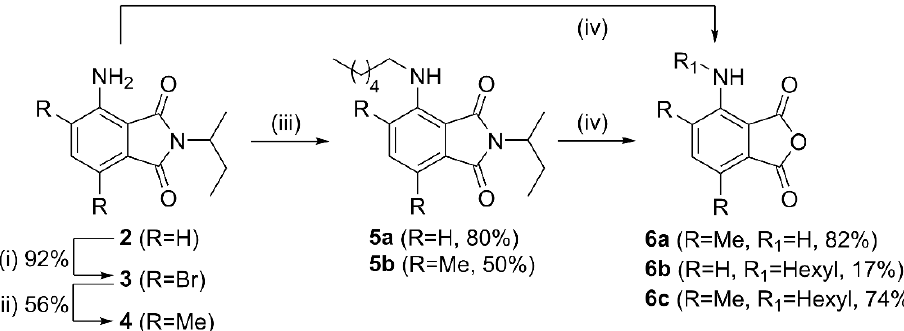
Figure 3. Synthesis of phthalic acid anhydride derivatives 6a – c . Reagents and conditions: ( i ) Br 2 , HOAc, NaOAc, r.t., 18 h, ( ii ) trimethylboroxine, Pd(PPh 3 ) 4 , K 2 CO 3 , H 2 O, 1,4-dioxane 105 o C, 18 h, ( iii ) 1-iodohexane, NMP, 110 °C, 2d, ( iv ) 15N aq. KOH, EtOH, reflux, 3 d.